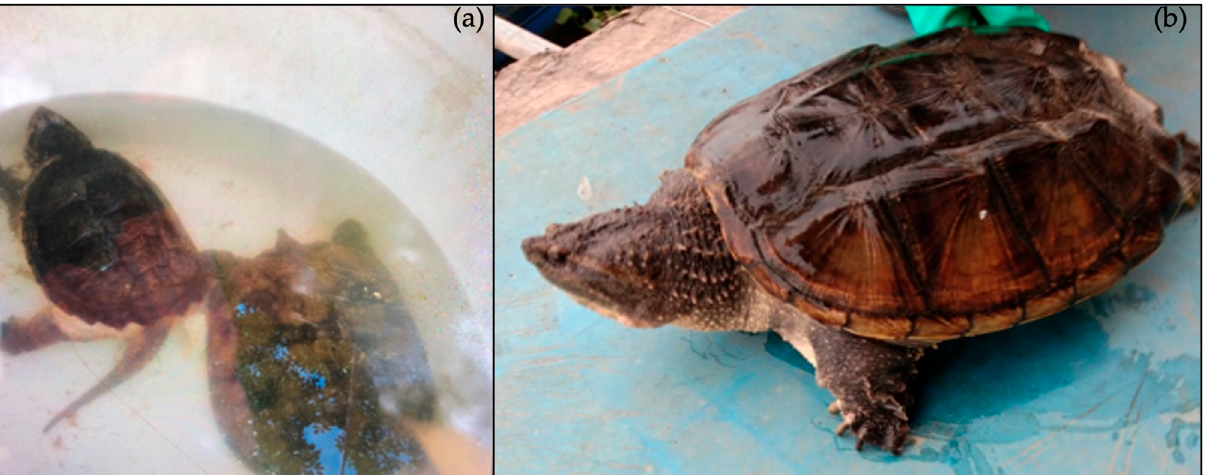
Figure 2. Turtle diversity observed during the interviews in Lao Cai and Yen Bai provinces in northern Vietnam: ( a ) fisherman on the Chay River; ( b ) water reservoir upstream of the dam (Chay River); ( c ) Sacalia quadriocellata ; ( d ) Mauremys sinensis ; ( e ) Palea steindachneri and ( f ) Amyda cartilaginea .